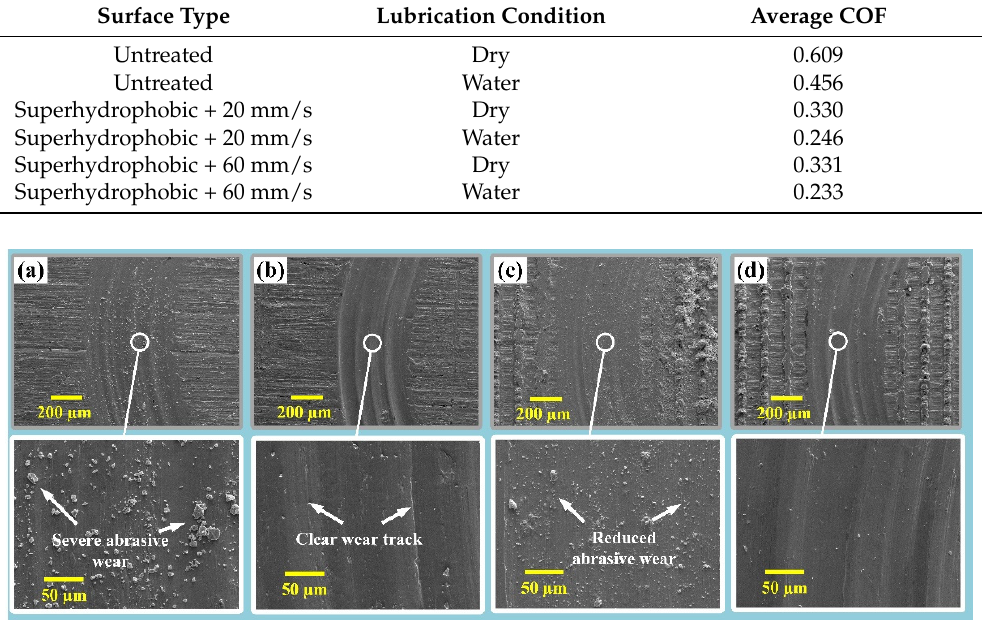
Figure 8. SEM images of the worn surfaces under different conditions: ( a ) untreated surface with dry sliding; ( b ) untreated surface with water lubrication; ( c ) laser-heat-treated surface with dry sliding; ( d ) laser-heat-treated surface with water lubrication.